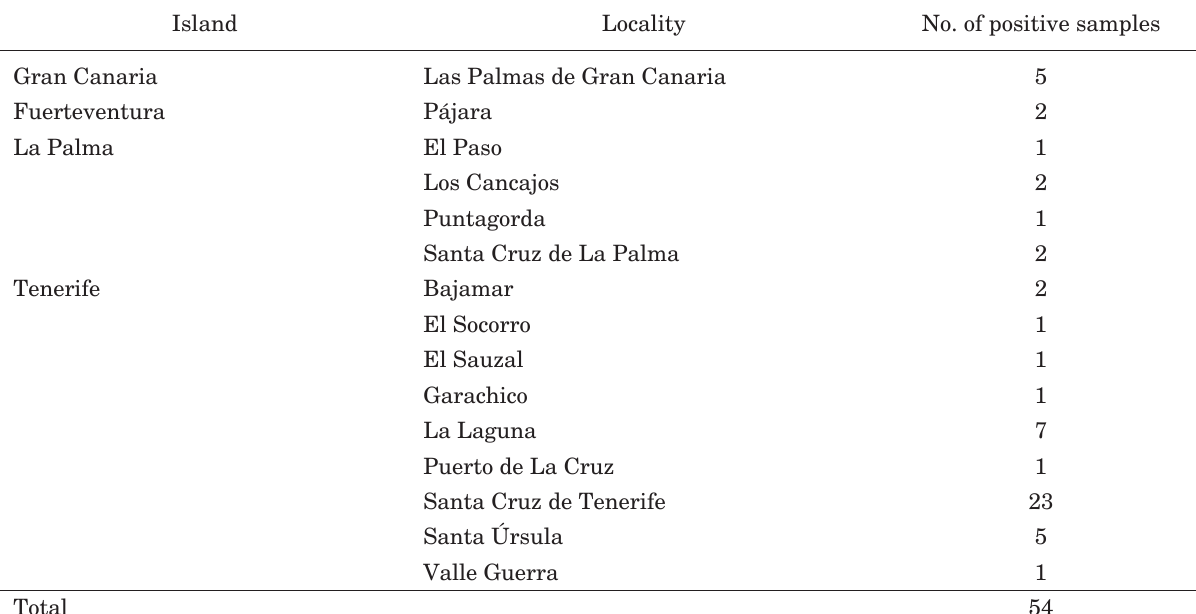
Table 1. Distribution of Fusarium oxysporum f. sp. canariensis in Phoenix canariensis collected from gardens and public parks in the Canary